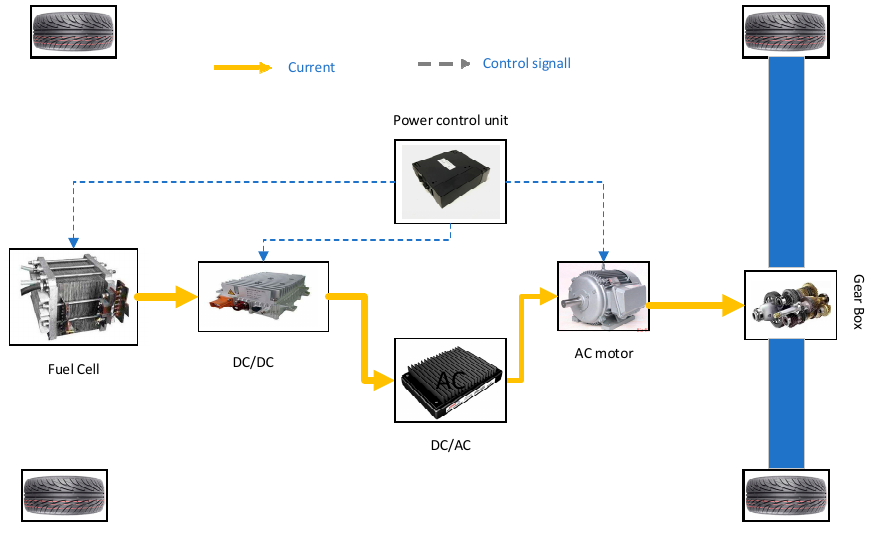
Figure 11. Fuel-cell vehicle (FCV) power system structure model.